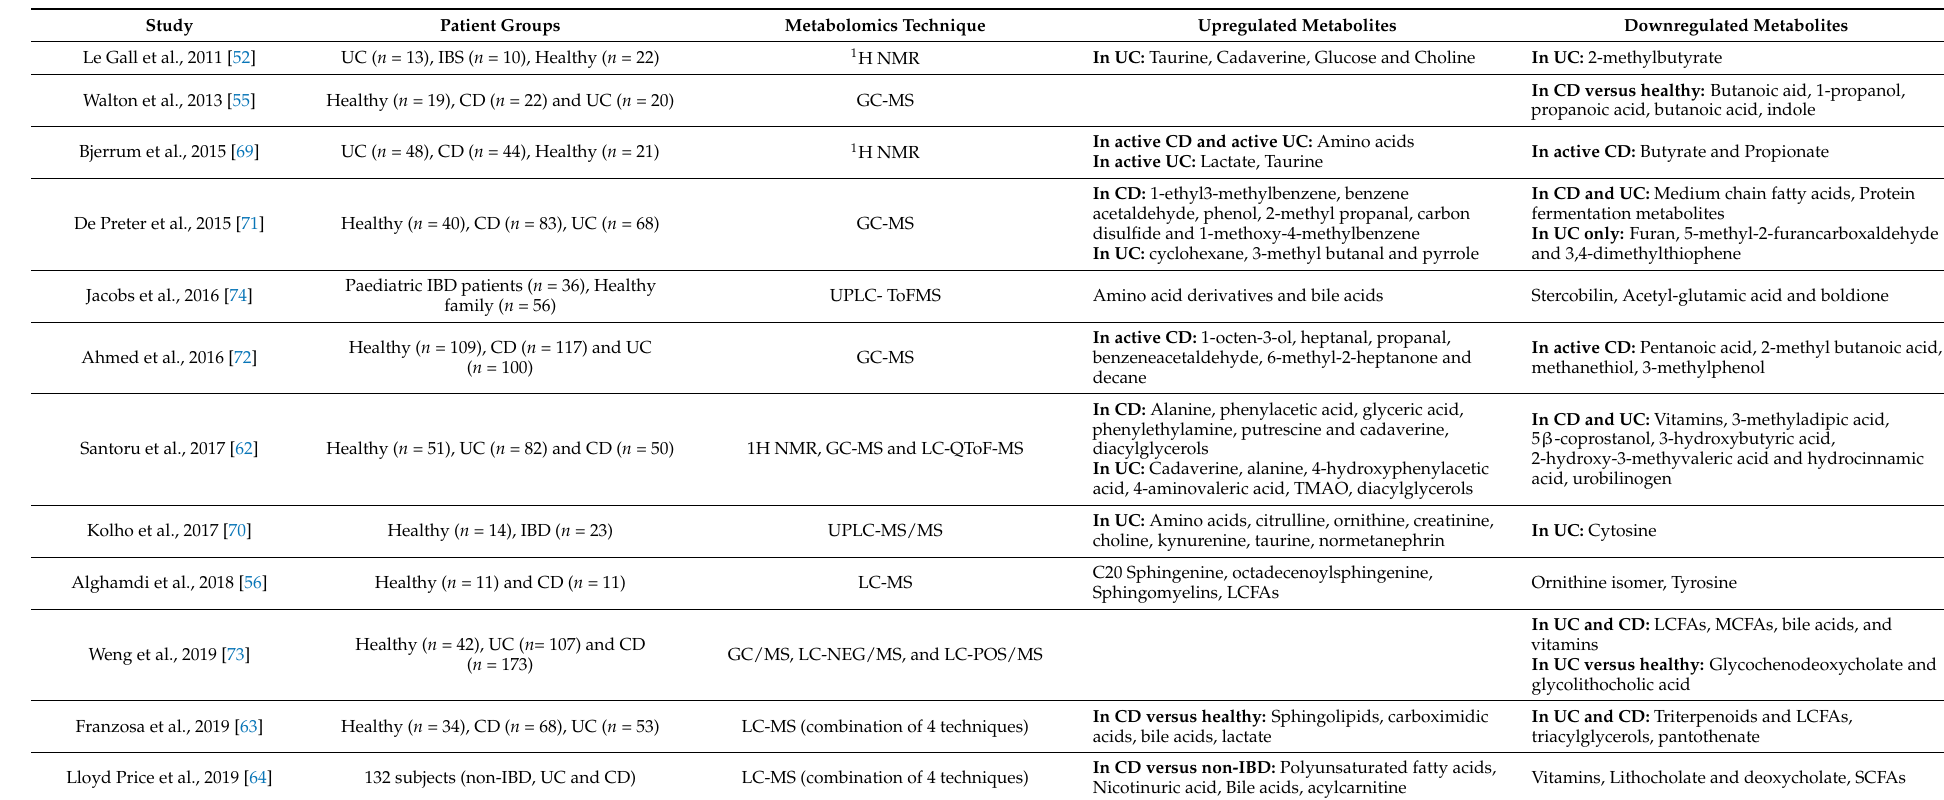
Table 1. List of studies performing untargeted comparative faecal metabolomics in